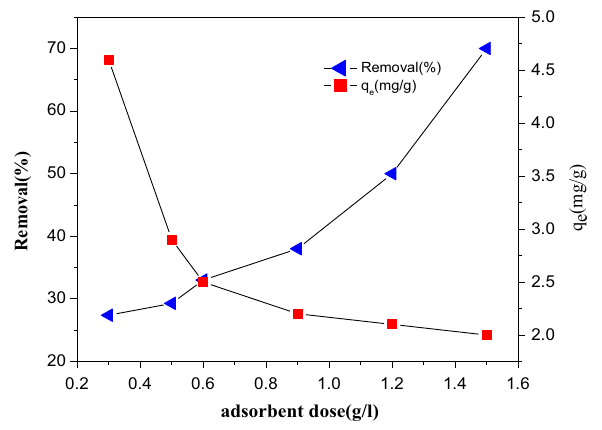
Fig. 4 Effect of adsorbent dosage on removal efficiency of PC-G on MgO nanoparticles. ( C 0 = 50 mg/L, pH = 3, and contact time = 60 min)